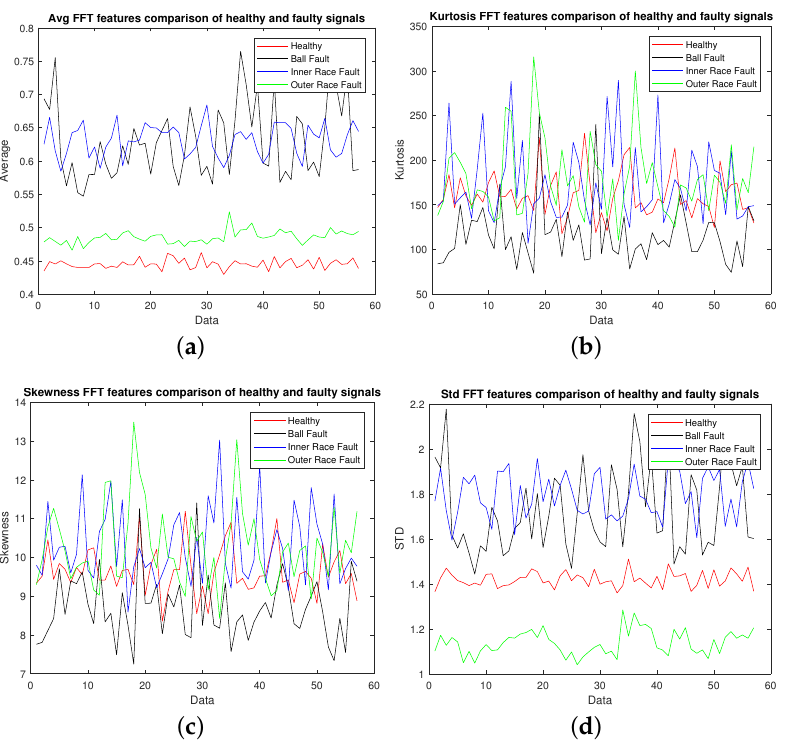
Figure 4. FFT signal demonstration: ( a ) Average, ( b ) Kurtosis, ( c ) Skewness, ( d ) Standard